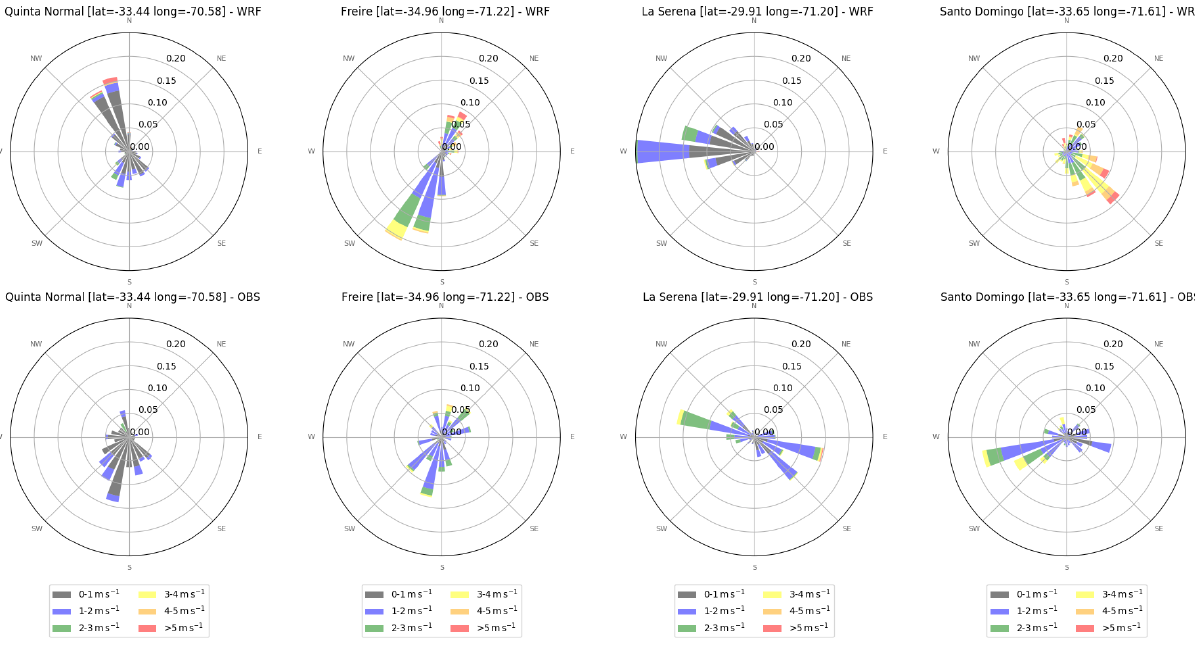
Figure A3. Same as Fig. A2 for wintertime in